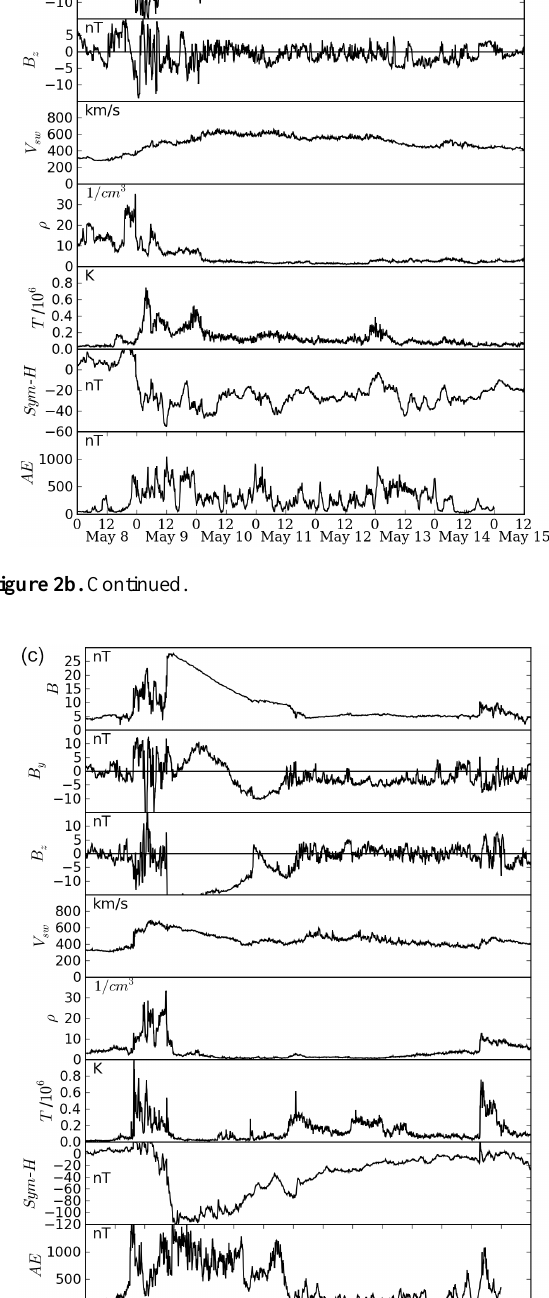
Figure 2a. Solar wind parameters from the OMNI data set for the four events studied is this paper. (a) April 2011; (b) May 2012; (c) July 2012; (d) November 2012.